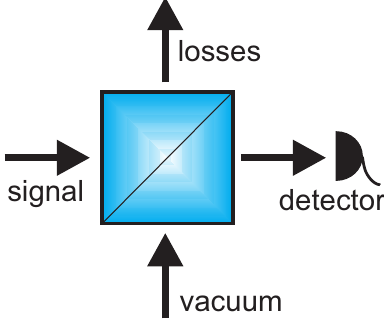
Figure 4. Fictitious beam splitter as a model of imperfect detection. The signal is both attenuated (non-unit efficiency) and contaminated by vacuum fluctuations entering the second